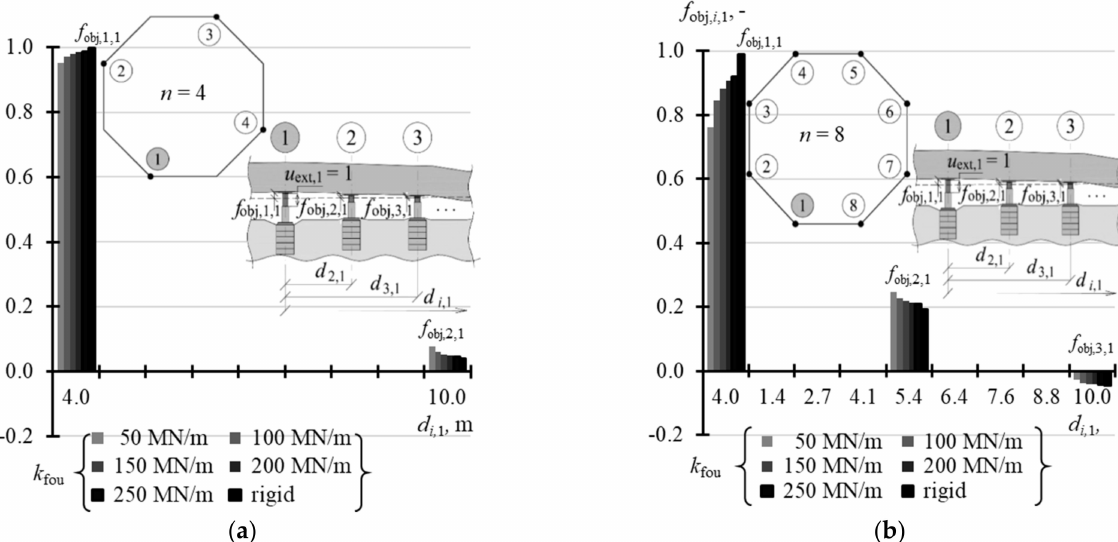
Figure 18. Elements of the matrix f obj for different stiffness values k fou of the jack support for: ( a ) n = 4; ( b ) n = 8.